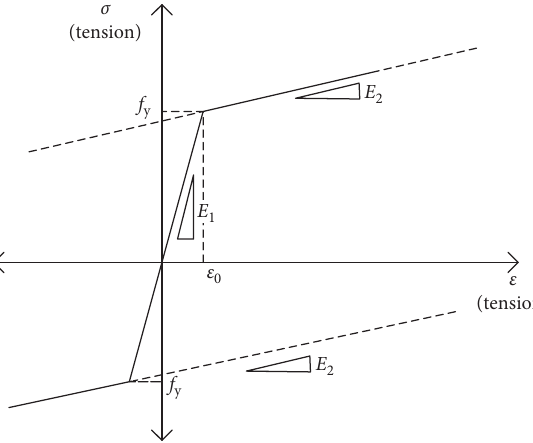
Figure 26: Stress-strain curve of reinforcement. Table 15: Cracking, yield, and ultimate strengths and corresponding curvature values of piles 1–4.